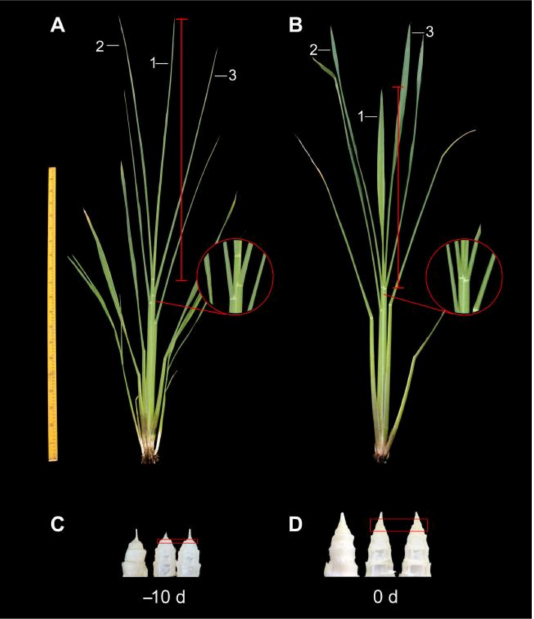
Figure 1. Photographs showing the morphology of plants and stem galls of Jiaobai. ( A , B ) External morphological characteristics of Jiaobai plants. ( C , D ) Longitudinal section of stem gall. − 10 d, 10 days before stem-gall formation; 0 d, the initial stage of stem-gall formation; red circles, the junction of leaf sheath and leaf. Red frame, the tissue for the mixed transcriptome analysis of Z. latifolia and U. esculenta